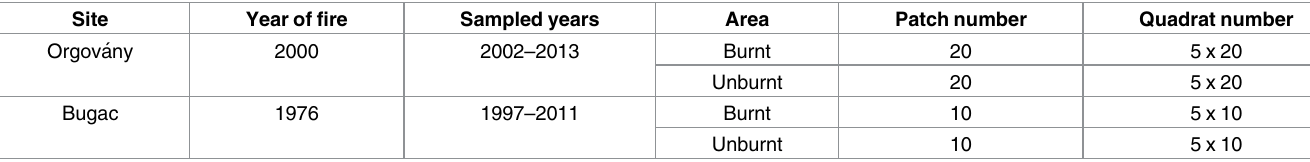
Table 1. Summaryof observation